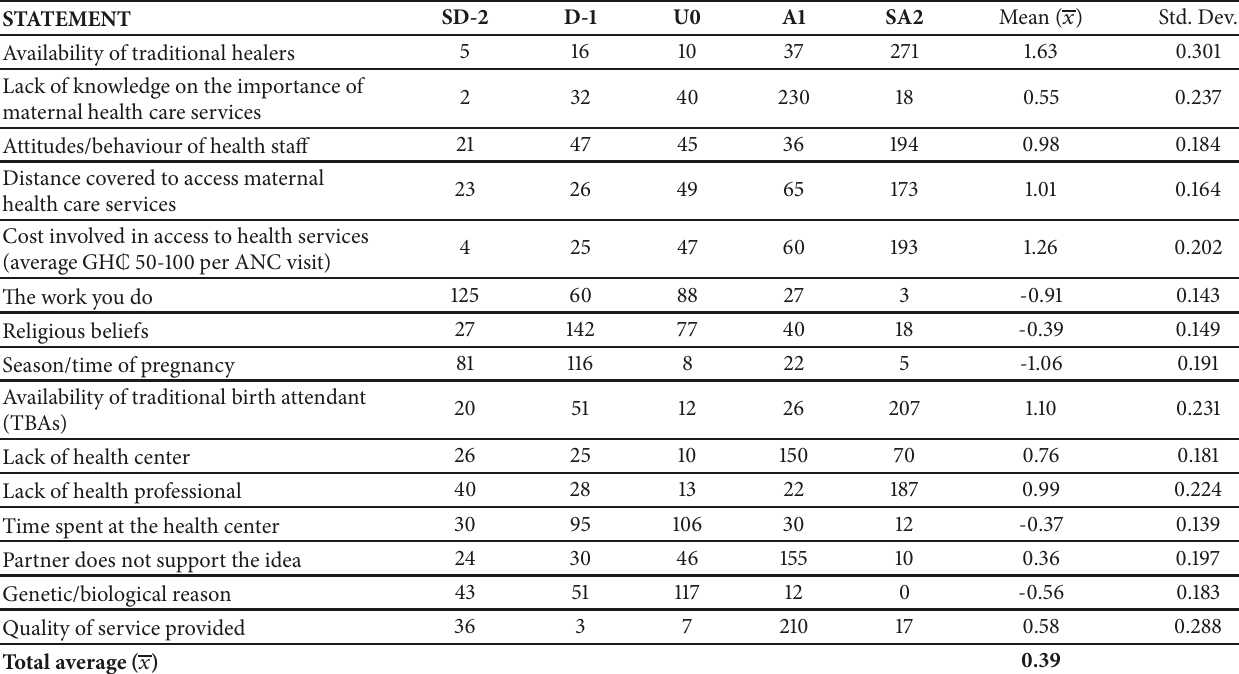
Table 5: Reasons for women’s nonuse of maternal health care services.